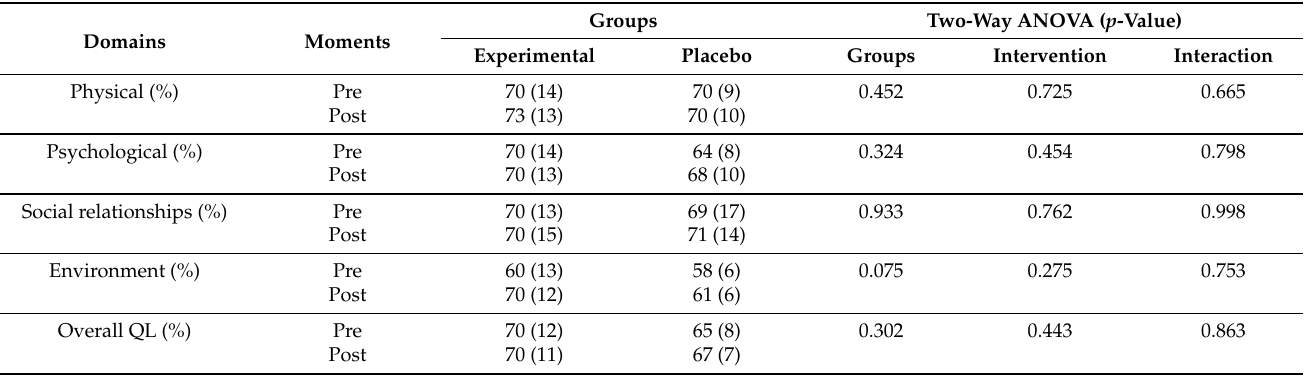
Table 3. Quality of life (WHOQOL-Bref) before and after